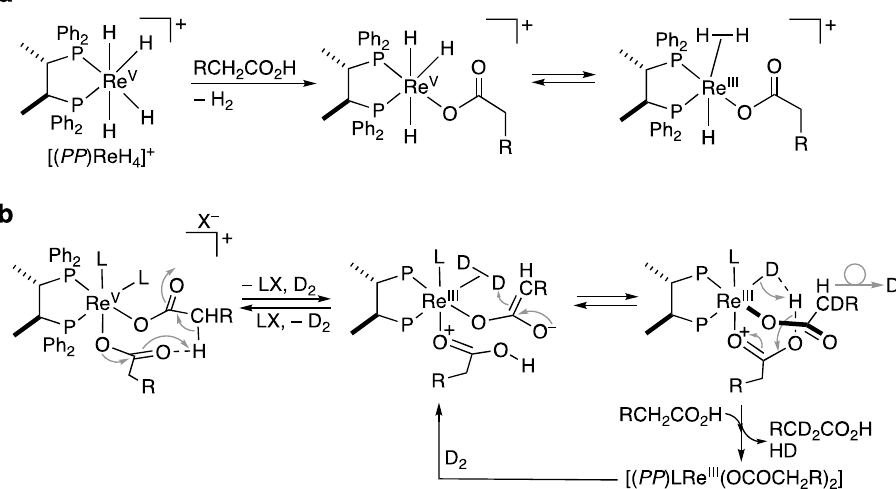
Figure 6. Proposed mechanism for the catalytic hydrogenation, and the deprotonation of α -C–H (R = PhCH 2 or alkyl). ( a ) Formation of [( PP )ReH 3 (OCOCH 2 R)] + for the “CA-self-induced hydrogenation of CA”. ( b ) Initial deprotonation and subsequent iterative H–D exchange reactions of CA, which form the catalytic cycle (L and X = D, Cl, or RCH 2 CO 2 ). The CA (R ′ CO 2 H) and carboxylate (R ′ CO 2– ) (irrespective of how many deuterium atoms are incorporated at the α -position, i.e., α - C - d 0 , α - C - d 1 , or α - C - d 2 ) attached to a Re center could mutually interchange by intramolecular proton transfer [(R ′